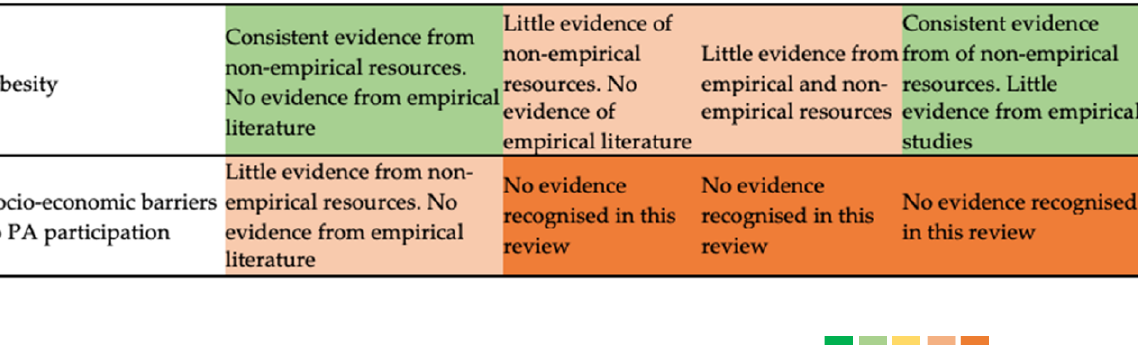
Figure 2. Colour-coded matrix based on quantity of evidence available of UK content and delivery strategies of PA promotion training to HCPs. Table 2. E-learning and online training resources stated within included